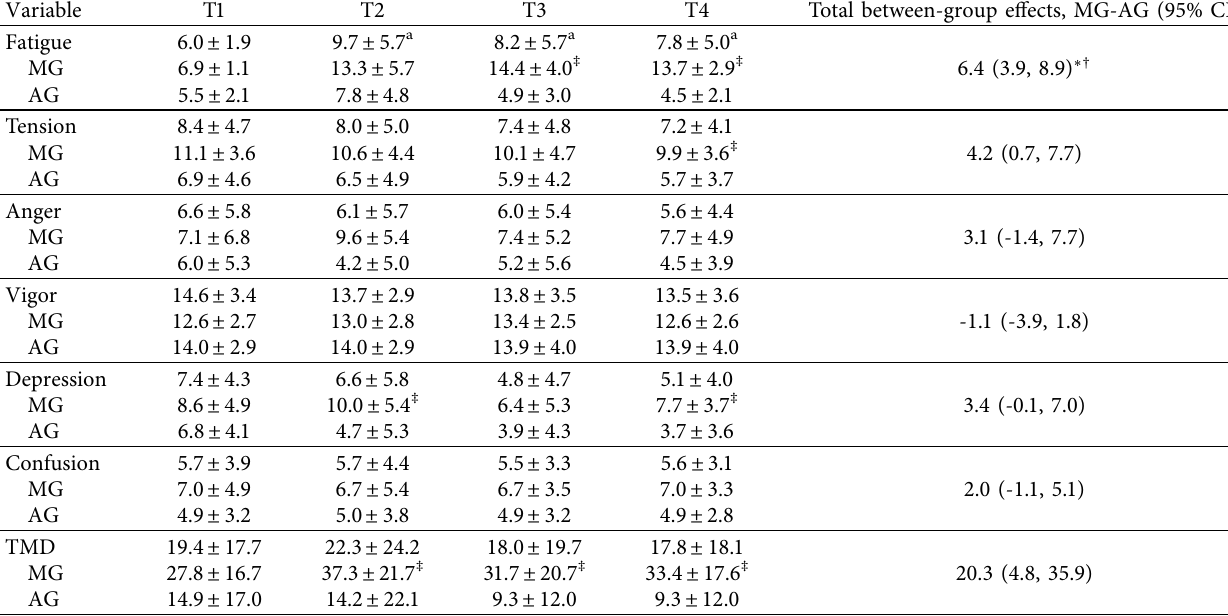
Table 3: Mean ± SD and between-group effects as mean difference (95% confidence interval) for fatigue, total mood state, and other POMS scores corresponding to different phases of an athletic